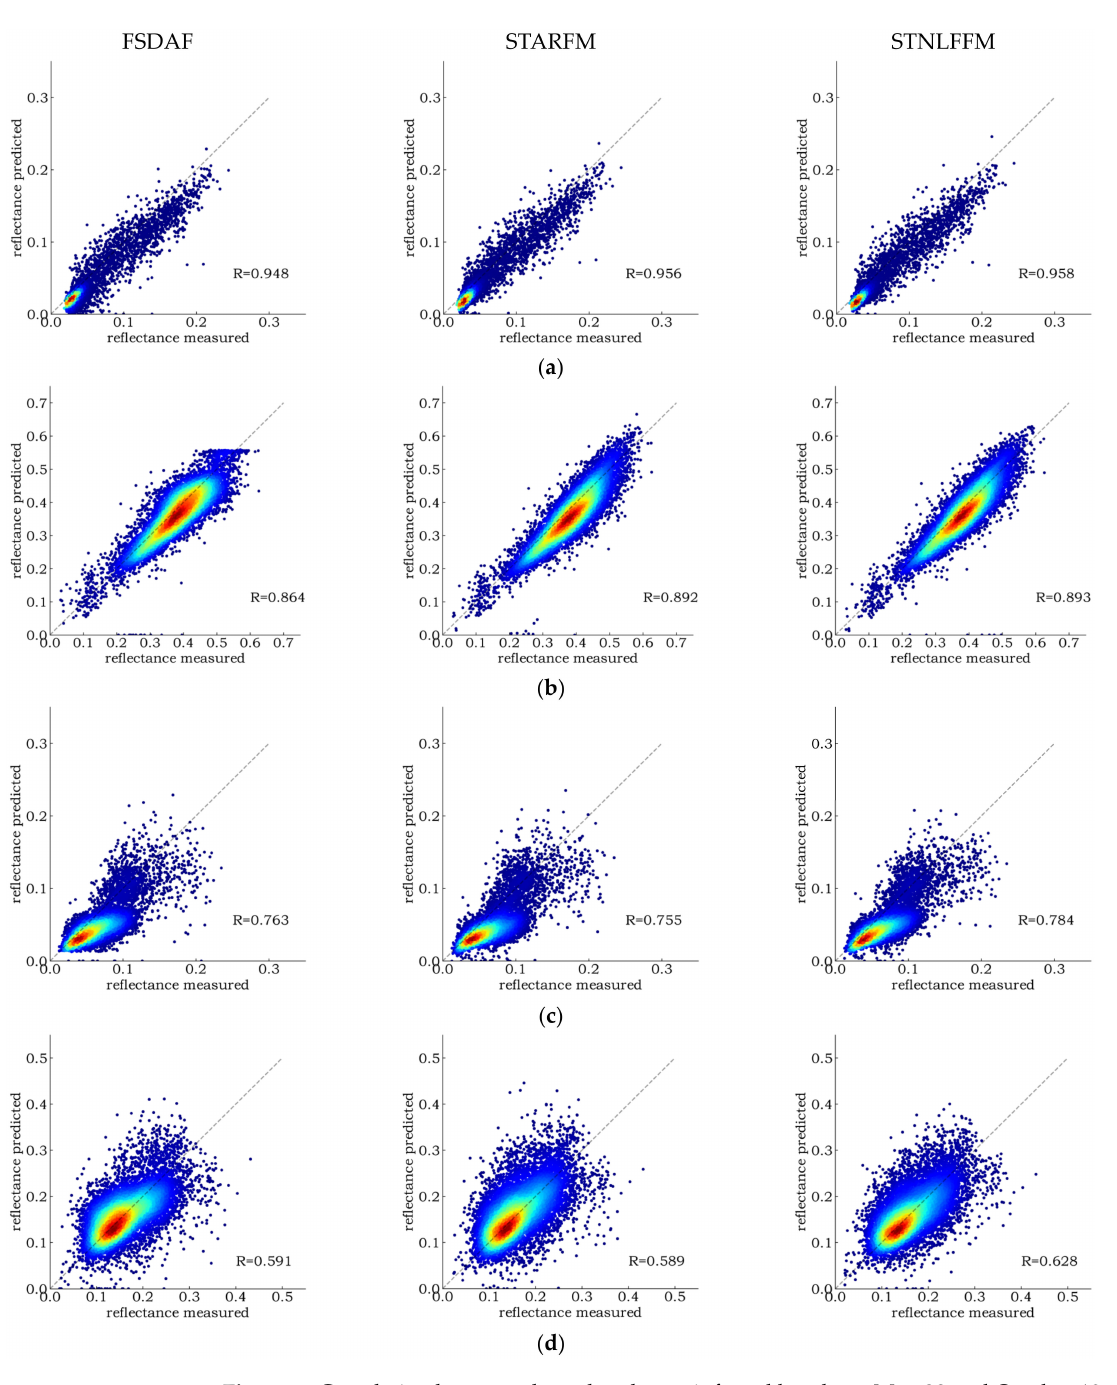
Figure 8. Correlation between the red and near-infrared bands on May 28 and October 19. ( a ) Corre- lation coefficient of the red band on May 28. ( b ) Correlation coefficient of the NIR band on May 28. ( c ) Correlation coefficient of the red band on October 19. ( d ) Correlation coefficient of the NIR band on October